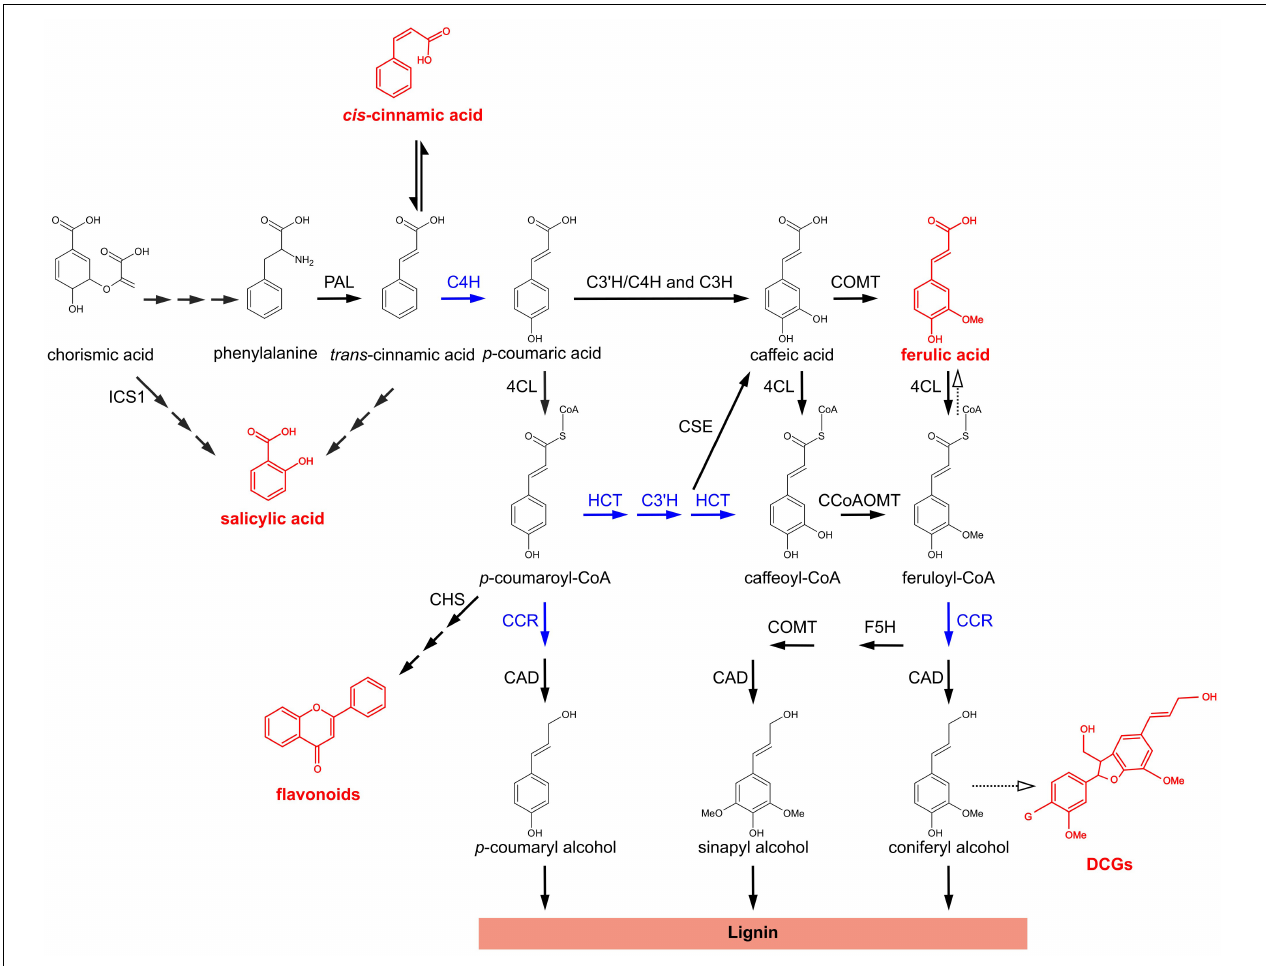
FIGURE 1 | The phenylpropanoid pathway in Arabidopsis thaliana . Metabolic pathway showing the biosynthesis of different classes of phenylpropanoids and phenylpropanoid-derived compounds. For flavonoids and DCGs a molecular structure is shown representative for their respective class of compounds. Metabolites and metabolite classes shown in red are discussed in this work for their (putative) role in the phenotypes of lignin mutants. Blue arrows indicate enzymatic steps upon which perturbation leads to the accumulation of bioactive molecules that have been proposed to be implicated in dwarfing of lignin mutants; solid arrows represent enzymatic steps validated by experimental evidence; dashed arrows represent suggested enzymatic steps/pathways; two or more successive smaller solid arrows represent multiple enzymatic steps. PAL, PHENYLALANINE AMMONIA-LYASE; C4H, CINNAMATE 4-HYDROXYLASE; 4CL, 4-COUMARATE:CoA LIGASE; HCT, p -HYDROXYCINNAMOYL-CoA:QUINATE/SHIKIMATE p -HYDROXYCINNAMOYLTRANSFERASE; C3 (cid:48) H, p -COUMAROYL SHIKIMATE/QUINATE 3 (cid:48) -HYDROXYLASE; C3H, p -COUMARATE 3-HYDROXYLASE; CSE, CAFFEOYL SHIKIMATE ESTERASE; CCoAOMT, CAFFEOYL-CoA O -METHYLTRANSFERASE; CCR, CINNAMOYL-CoA REDUCTASE; F5H, FERULATE 5-HYDROXYLASE; COMT, CAFFEATE O -METHYLTRANSFERASE; CAD, CINNAMYL ALCOHOL DEHYDROGENASE; ICS1, ISOCHORISMATE SYNTHASE 1; CHS, CHALCONE SYNTHASE; DCGs, dehydrodiconiferyl alcohol glucosides; G, glucose.